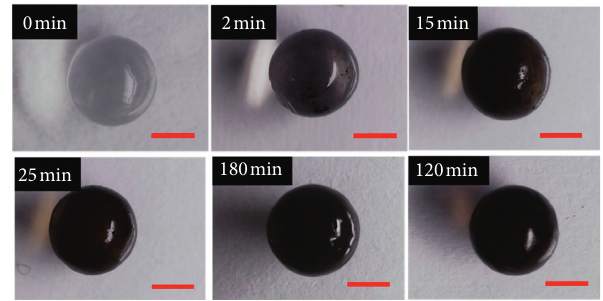
Figure 2: Images of mm-MWNTs-PDA@CaSA-Caps during the reaction process. Scale bar is